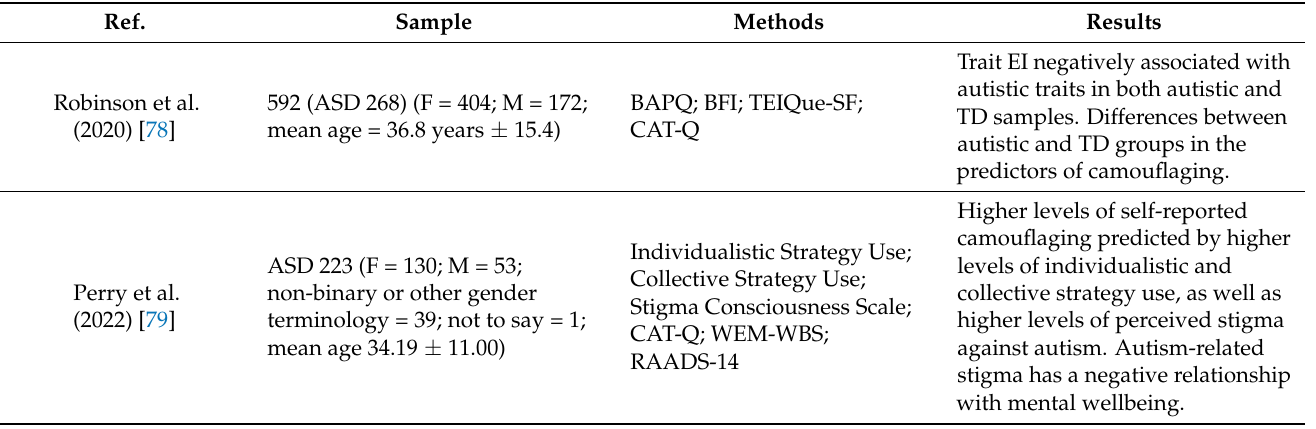
Table 5. The available literature on Social Camouflaging (Part 5).